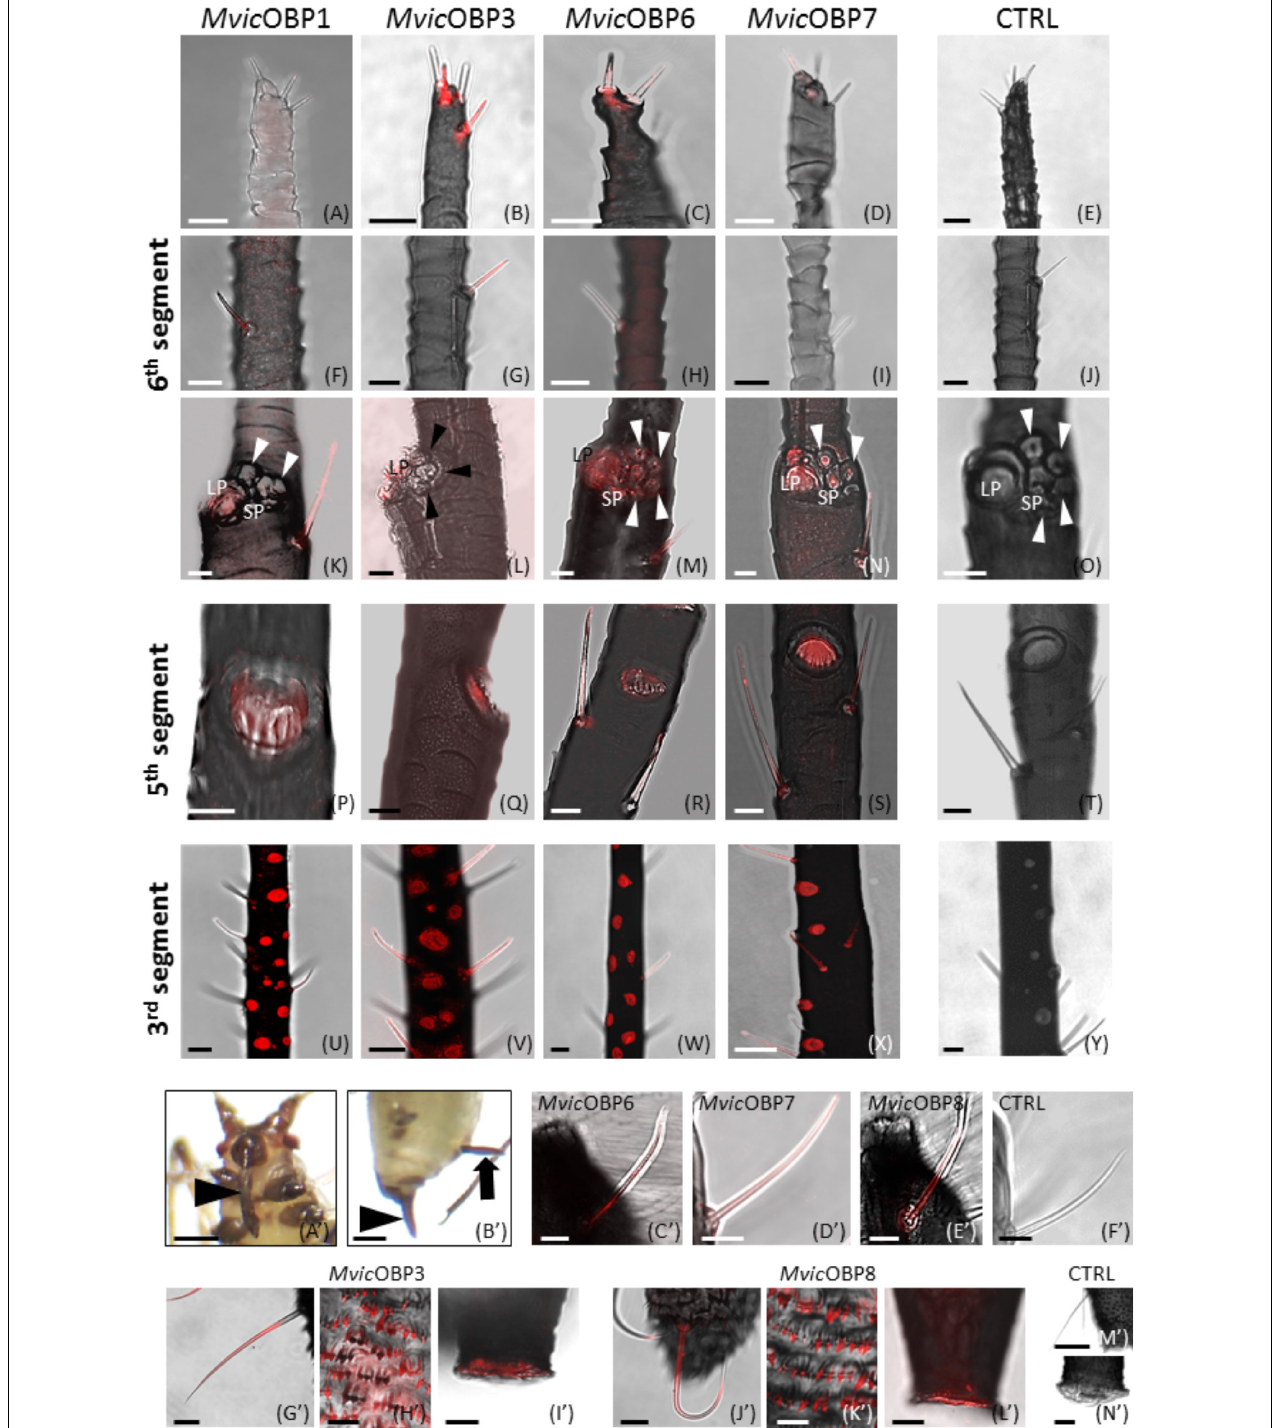
FIGURE 4 | (A–Y) Whole-mount immunolocalization experiments showing the OBP expression in type II trichoid sensilla located on the antennal tip (A–D) , in type II trichoid sensilla on the 6th antennal segment (F–I) , in primary rhinaria on the 5th (K–N) and 6th segments (P–S) and in secondary placoid sensilla on the 3rd segment (U–X) . (E,J,O,T,Y) Negative controls. Bars in (A–T) , 10 µ m; bars in (U–Y) , 25 µ m. (A’–N’) Whole-mount immunolocalization experiments showing the OBP localization in the mouthparts (arrowhead in (A’) ), in the cauda (arrowhead in (B’) ) and in cornicles (arrow in (B’) ). (E–G,C’–E’) Immunolocalization of OBPs in the long sensilla on the labium sides. (G’–L’) OBPs detection in hair-like structures and finger-like projections in cauda and in cornicles. (F’,M’,N’) Negative controls. Bars in (A’,B’) , 250 µ m; bars in (C’–F’,H’,K’) , 10 µ m; bars in (M’) , 50 µ m; bars in (G’,I’,J’,L’,N’) , 20 µ m